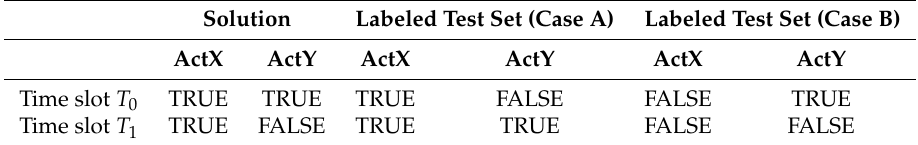
Table 5. Time slots evaluation